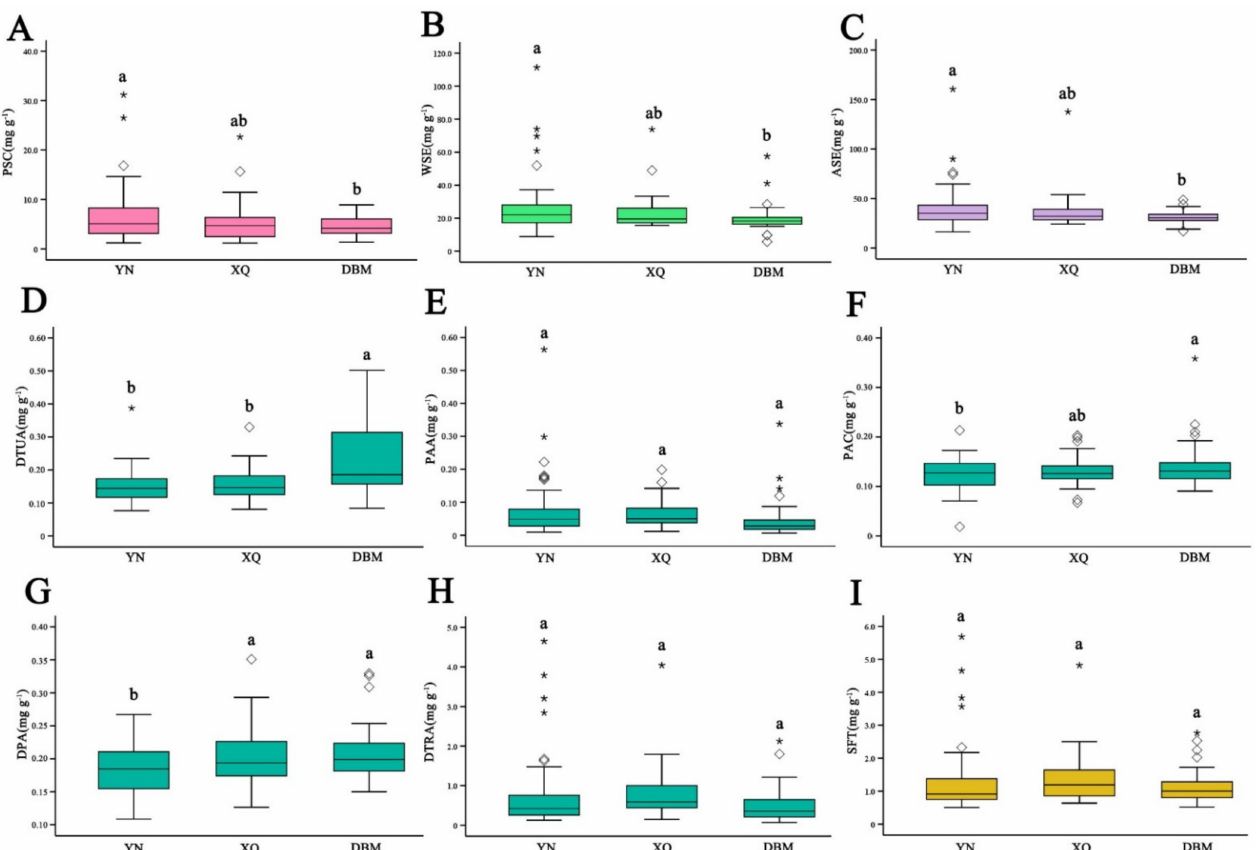
Figure 1. Box and whisker plot of polysaccharides (PSC, A ), water-soluble extract (WSE, B ), alcohol- soluble extract (ASE, C ), triterpene acids DTUA ( D ), PAA ( E ), PAC ( F ), DPA ( G ), DTRA ( H ) and sum of five triterpenoids (SFT, I ) in cultivation regions of PC. Data are mean values ± SD (significant differences between the letters). The boxes are bounded by the 25% and 75% quartiles, with the median inside, whereas the extreme levels correspond to 5% and 95% percentiles, the rhombuses and stars represent the atypical